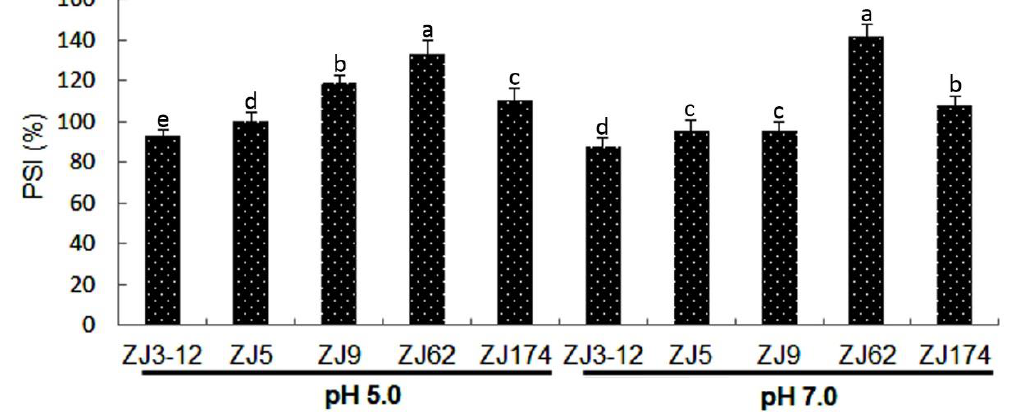
Figure 1. Phosphate solubilization index (PSI)% of five bacterial strains (ZJ3-12, ZJ5, ZJ9, ZJ62 and ZJ174) was determined by inoculating bacteria on National Botanical Research Institute Phosphate (NBRIP) media at pH 5.0 or pH 7.0 and measuring the diameter of halo zone after 3 d of incubation. PSI = (diameter of colony + halo zone (cm) − diameter of colony (cm))/diameter of colony (cm) × 100 [19]. Vertical bars represent the standard deviation of the means (n = 3). Bars followed by the different letters are significantly different at p < 0.05 according to LSD. Table 1. The ability of the five selected bacterial strains in P-solubilization, siderophores production and N-fixation.